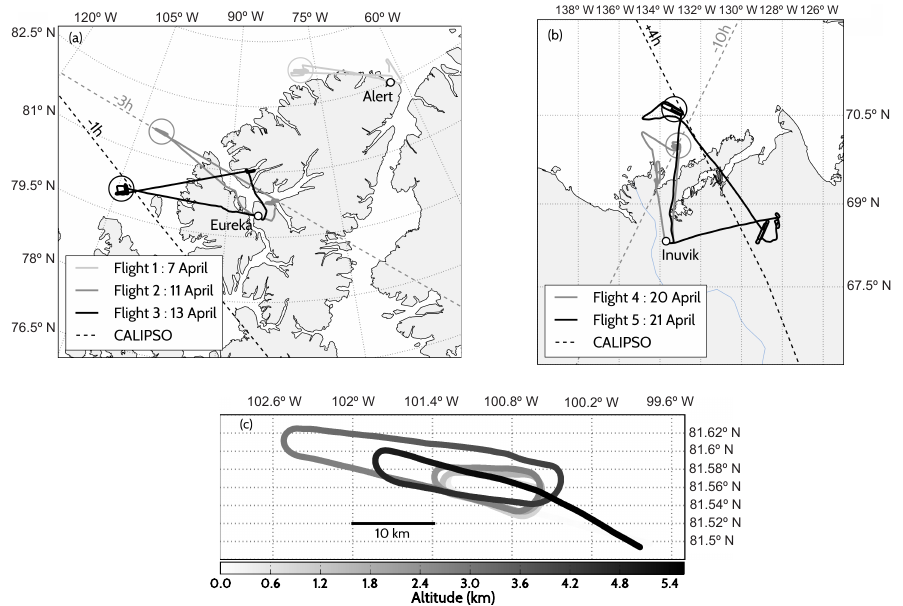
Figure 3. Selected flight trajectories around (a) Eureka and (b) Inuvik. The circles indicate where the detailed vertical profiles were per- formed. CALIPSO tracks are also shown and hours indicate how much earlier ( − ) or later ( + ) the satellite flew over. (c) Detailed spiral ascent for the 11 April